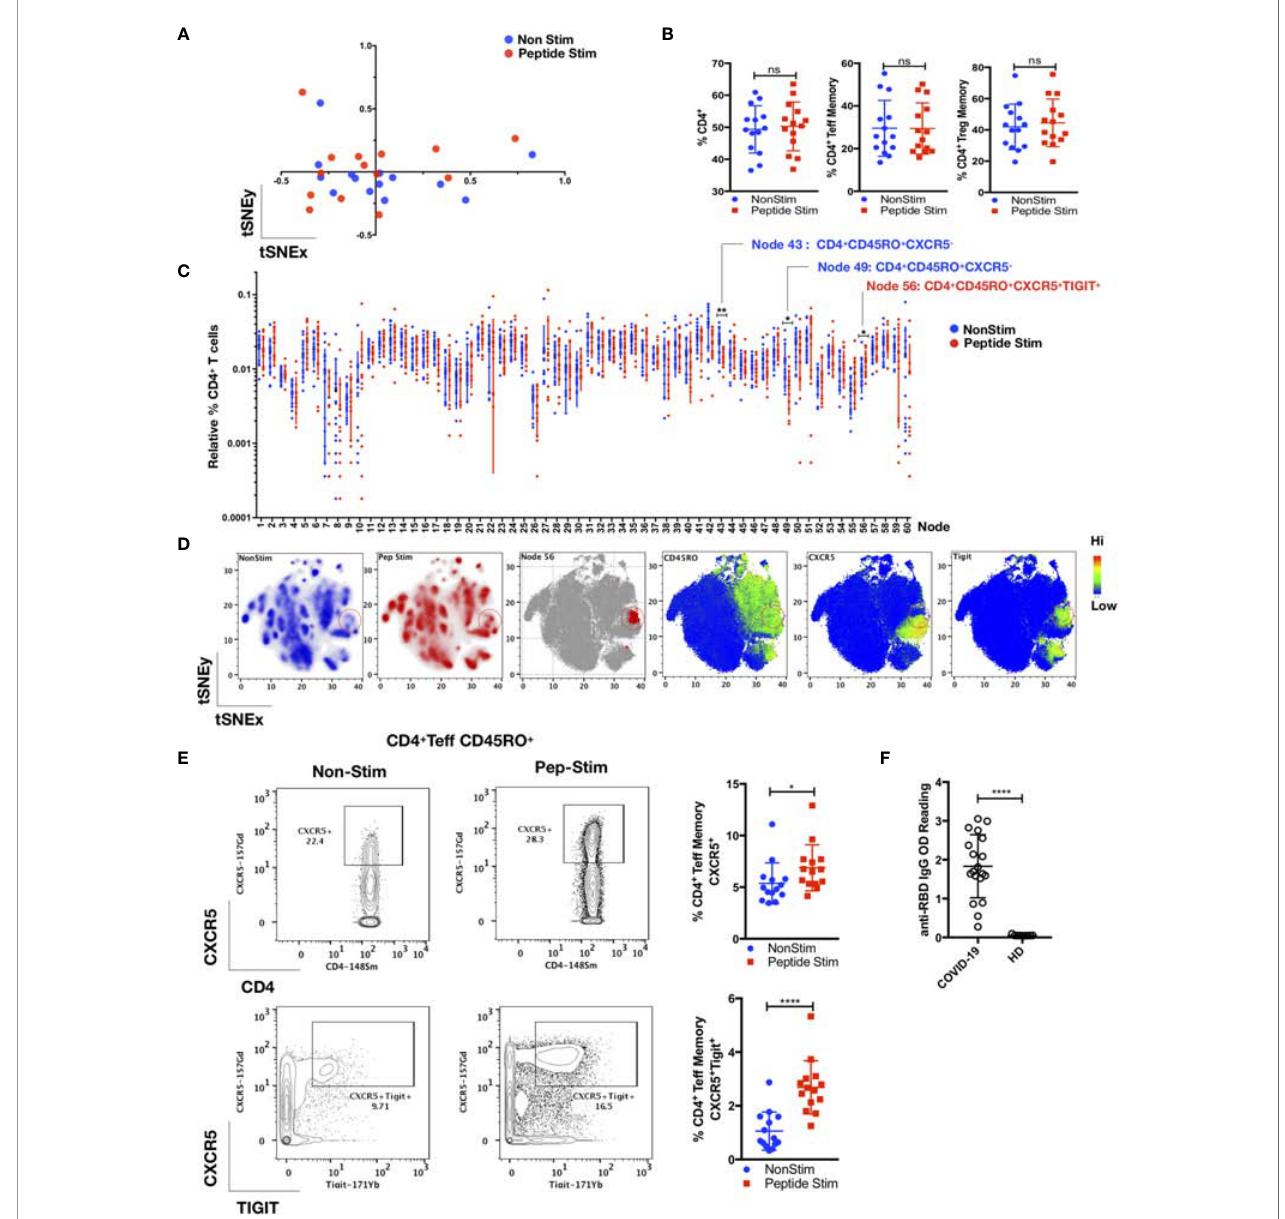
FIGURE 3 | TIGIT + T-follicular helper cells speci fi c for the RBD region of the SARS-CoV-2 spike glycoprotein are present in COVID-19 convalescent patients. PBMCs from convalescent patients (n = 14) were stimulated for 72 h with/without a peptide pool covering the RBD of the SARS-CoV-2 spike glycoprotein and interrogated with COVID panel (A) . (A) FlowSOM cluster frequencies of CD3 + CD14 - CD19 - CD4 + CD8 - T cells were dimensionally reduced with t-SNE. (B) Gated frequencies of CD3 + CD4 + , CD3 + CD4 + CD25 -/+ FoxP3 - (T eff )CD45RA - CD45RO + or CD3 + CD4 + CD25 + FoxP3 + (T reg )CD45RA - CD45RO + as percentages of CD3 + or CD4 + parent lineages. (C) Relative percentages of FlowSOM clusters (k = 60) of CD4 + T cells, with signi fi cant clusters re fl ected. Data represent the mean ± SD; Mann – Whitney U (two-tailed) test, * p < 0.05, ** p < 0.01. (D) tSNE maps re fl ecting density, location and marker expression of cluster 56 (red circles). (E) Frequencies of CD4 + CD25 +/- FoxP3 - (T eff ) CD45RO + CD45RA - CXCR5 + or CD4 + CD25 +/- FoxP3 - (T eff )CD45RO + CD45RA - CXCR5 + TIGIT + as a percentage of CD4 + T cells. Data represent the mean ± SD, Mann – Whitney U (two-tailed) test, * p < 0.05, **** p < 0.0001. (F) Anti-RBD IgG OD (optical density) readings of convalescent patient plasma (n = 19) and HD (n = 9). Data represent the mean ± SD, Mann – Whitney U (two-tailed) test, * p < 0.05, **** p < 0.0001. NonStim, peptide solvent control; Peptide Stim, stimulation with peptide pool; ns, statistically not signi fi